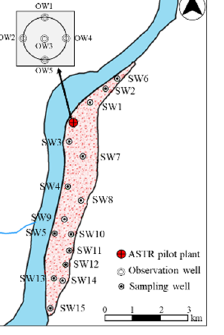
Figure 5. Boring test results of the observation and sampling wells in the Samrak Park, ( a ) location of wells, ( b ) well logs (modified from [21]).